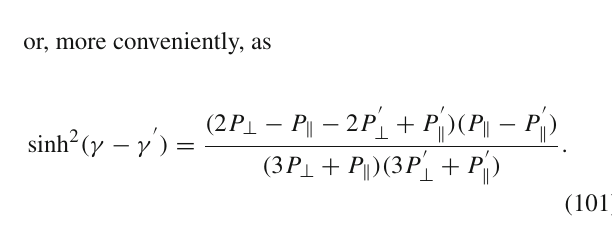
Fig. 15 Plot of Ω(σ,ξ, T , T (cid:2) ) as a function of ξ, T (cid:2) . Blue color denotes Ω = − 1, white color - Ω =